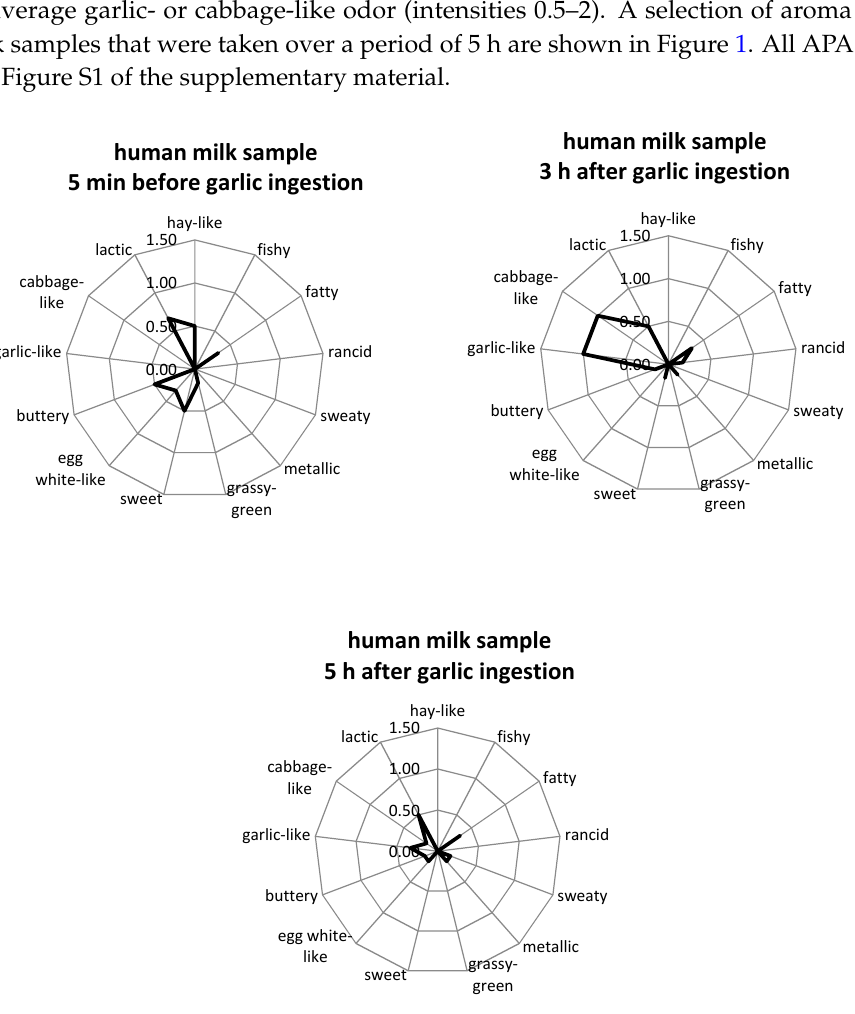
Figure 1. Odor profiles of human milk samples of test person c , as a representative example. The samples were collected at different times before and after ingestion of 3 g raw garlic. Panelists were asked to rate the orthonasal perception on a scale from 0 (no perception) to 3 (strong perception). Values are mean ratings of all panelists. Note: The scale is only presented up to the value of 1.5 for better visualization.